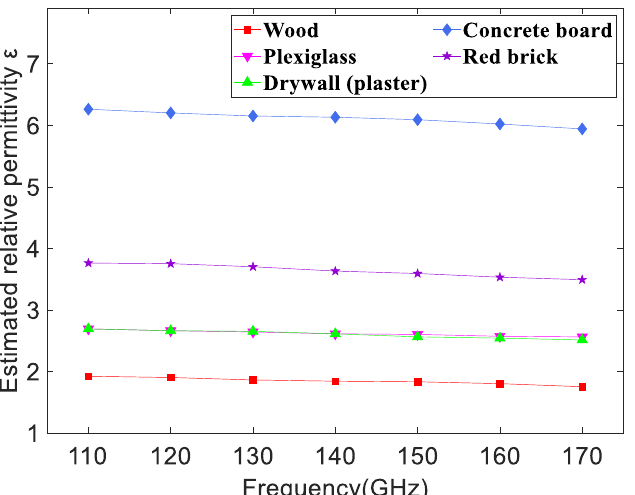
Figure 8. The relationship between estimated relative permittivity of five materials and frequencies in